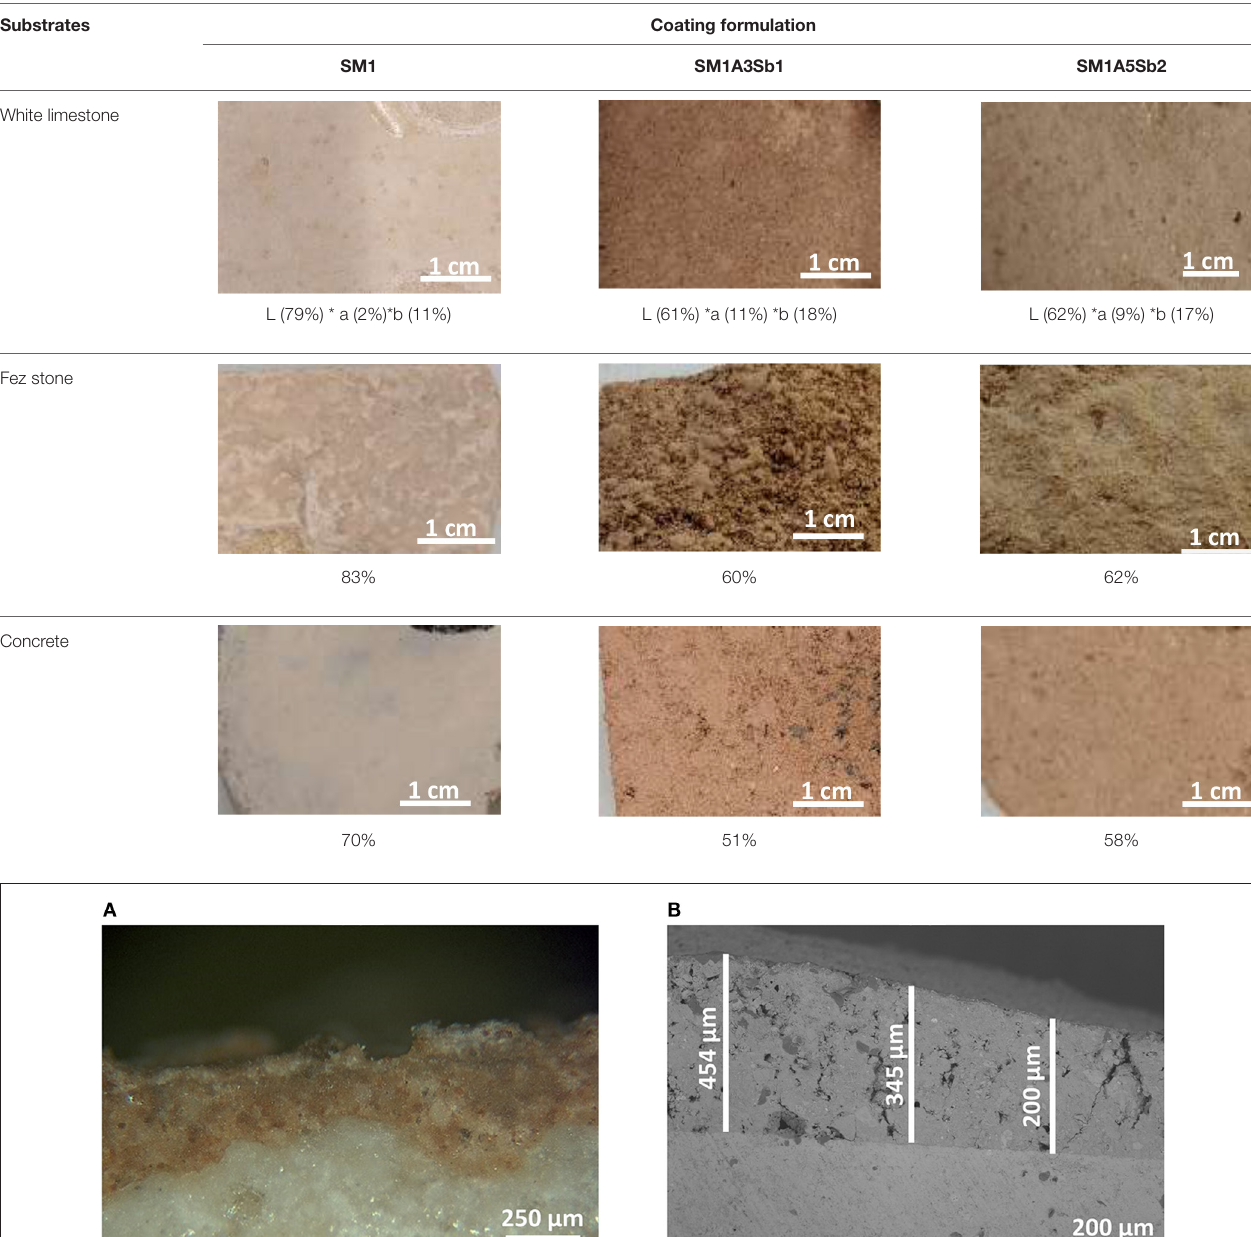
TABLE 3 | Pictures and lightness of SM1, SM1A3Sb1, and SM1A5 Sb2 coatings applied on white limestone, Fez stone, and concrete.